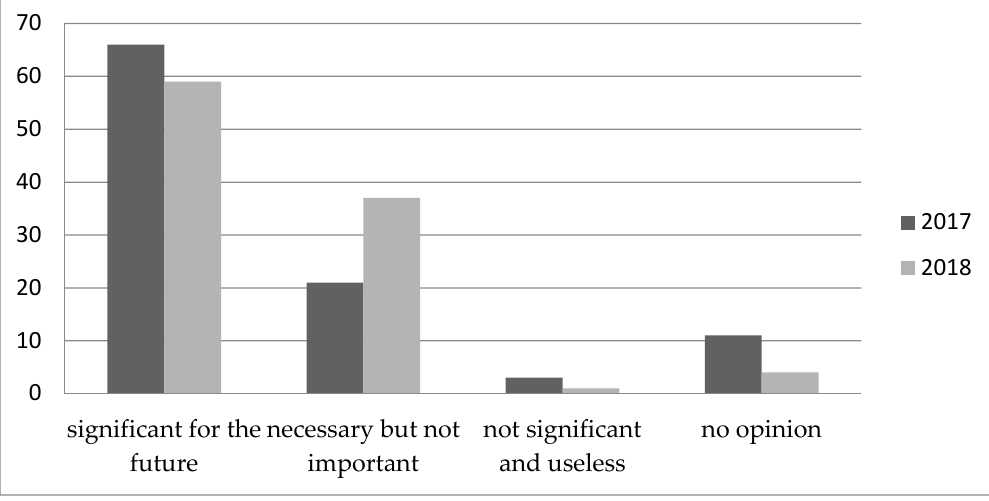
Figure 1. The significance of Industry 4.0 application, Industry 4.0 application in your company in %. Source: own processing based on survey results.